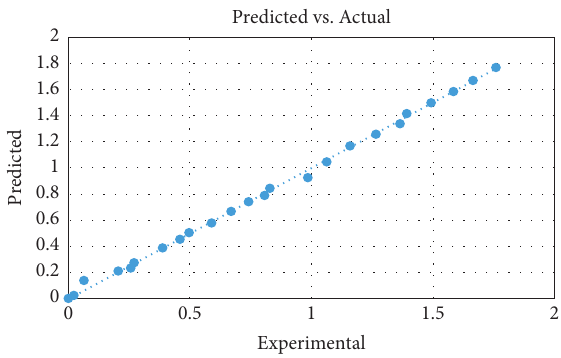
Figure 12: Correlation graph for Scheme A